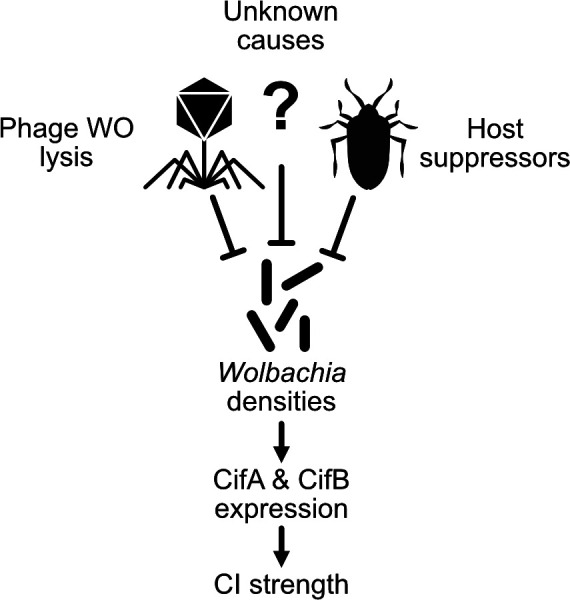
An expanding Wolbachia density model of CI strength variation.The proximal cause of CI is likely CifA and CifB, whose transcriptional level has been connected with intensity in transgenic studies (LePage et al., 2017). Wolbachia densities have often correlated with factors that influence CI strength variation (Werren, 1997). In many cases, it remains unknown how these factors influence Wolbachia densities. Phage WO lysis (Bordenstein and Bordenstein, 2011) and host suppressors are well documented correlates or causes of density changes (Funkhouser-Jones et al., 2018; Poinsot et al., 1998; Walker et al., 2011).